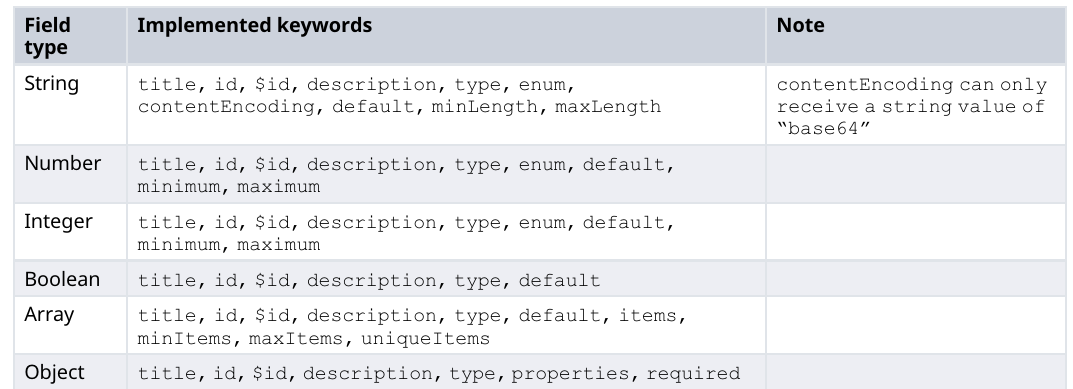
Table 1. Implemented JSON schema field types and their relevant keywords in Adamant v1.0.0. Note that the id keyword only works with the JSON schema specification version draft 4, whereas $id is used for the newer specification drafts. Lastly, the contentEncoding keyword is intended to be used with the specification version draft 7 or newer. JSON, JavaScript Object